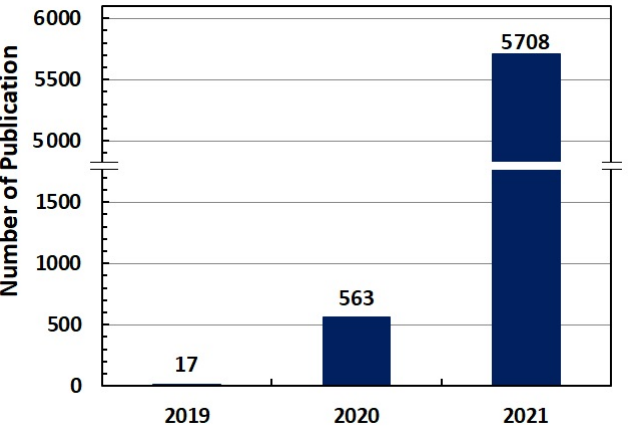
Figure 2. The Annual distribution of in COVID-19 vaccine research.